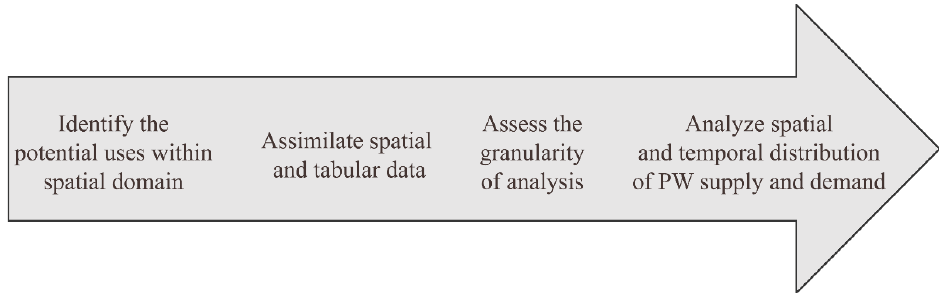
Figure 1. General framework for assessing demand of treated PW.